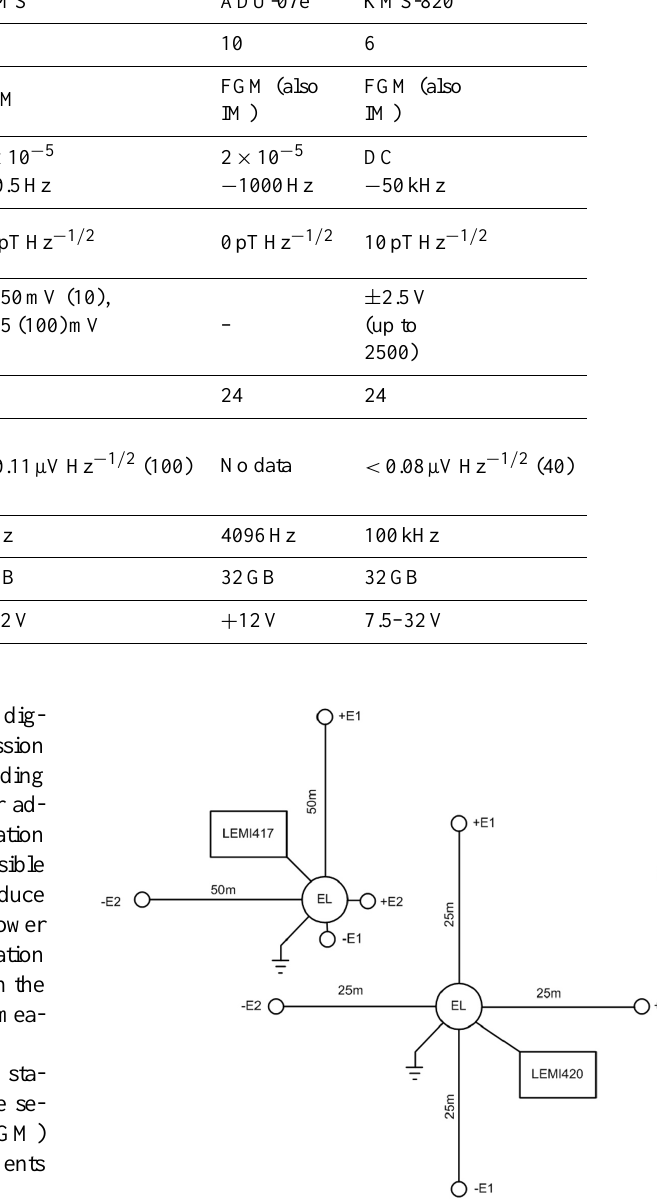
Figure 4. Electric channel